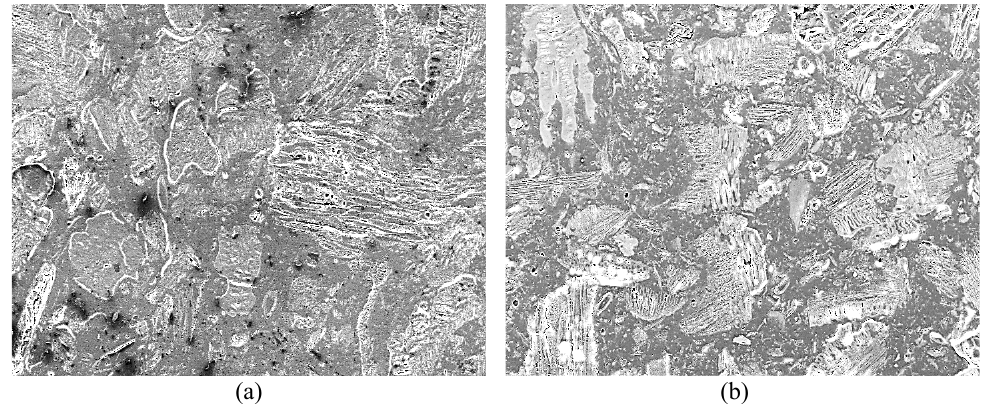
Figure 3. Scanning electron micrographs of the surfaces of PP/OPTP composites (70% pulp/26% PP/4% Exxelor PO 1020) produced with a pressing pressure of 50 tonnes and with ( a ) unheated and ( b ) 80 °C mould temperatures at 100× magnification.